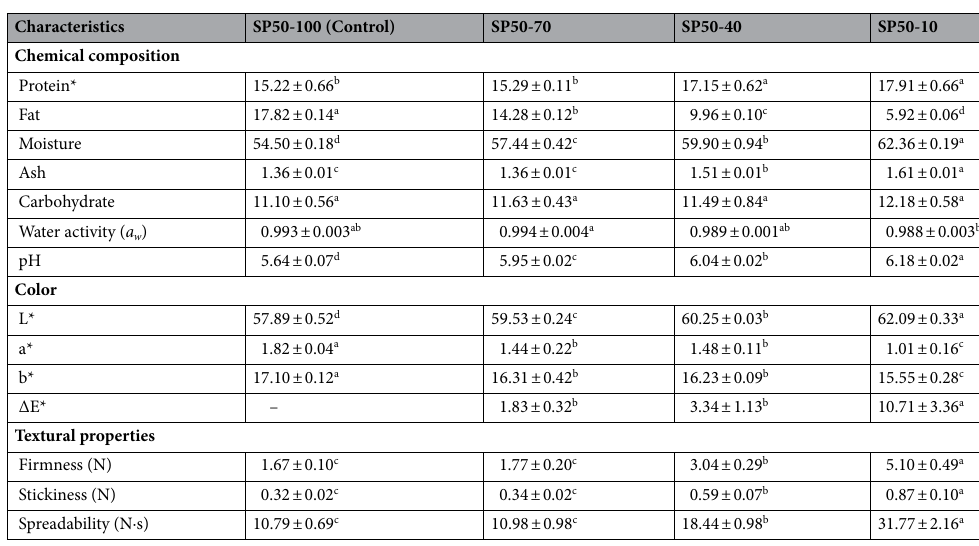
Table 3. Physicochemical characteristics of chicken bread spread-fortified with 50% of silkworm pupae with different levels of coconut oil. Data are expressed as mean ± standard deviation (n = 3; n = 6 for color and textural properties). *The conversion factor used is 6.25. SP50-100 (Control): Chicken bread spread with 50% replacement of chicken by silkworm pupae without fat reduction (100% coconut fat). SP50-70, SP50-40, and SP50-10: Chicken bread spread with 50% replacement of chicken by silkworm pupae using 70, 40, and 10% coconut oil in the control sample, respectively. Different lowercase superscripts within the same row indicate significant differences ( p ≤